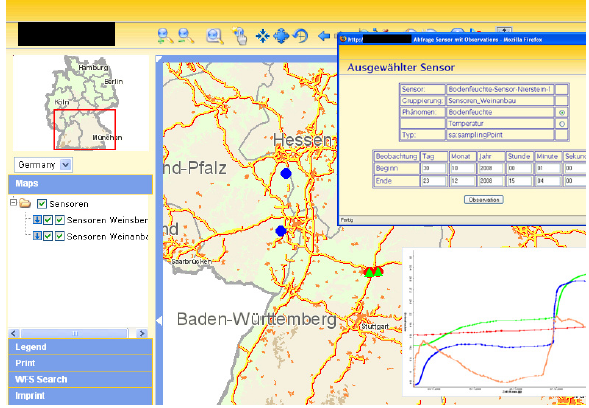
Figure 8. Administration client for event